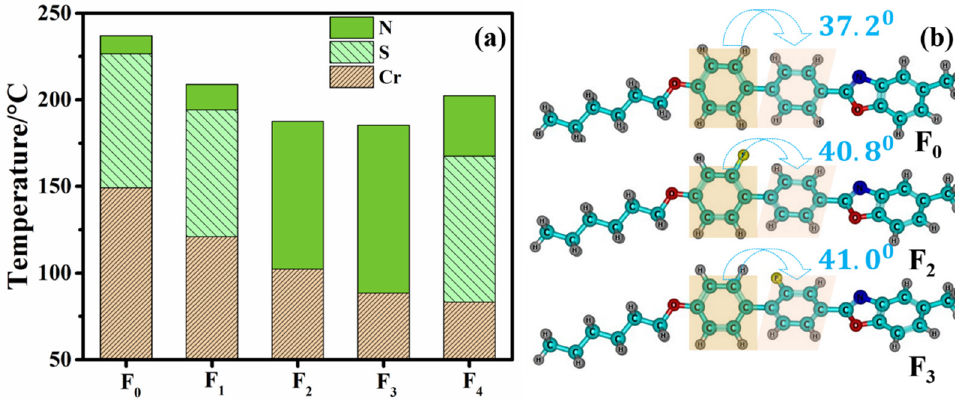
Figure 2. Phase transition temperature ( a ) of benzoxazole LC compounds and biphenyl dihedral angles ( b ) in the molecular configuration of compounds F 0 , F 2 and F 3 .